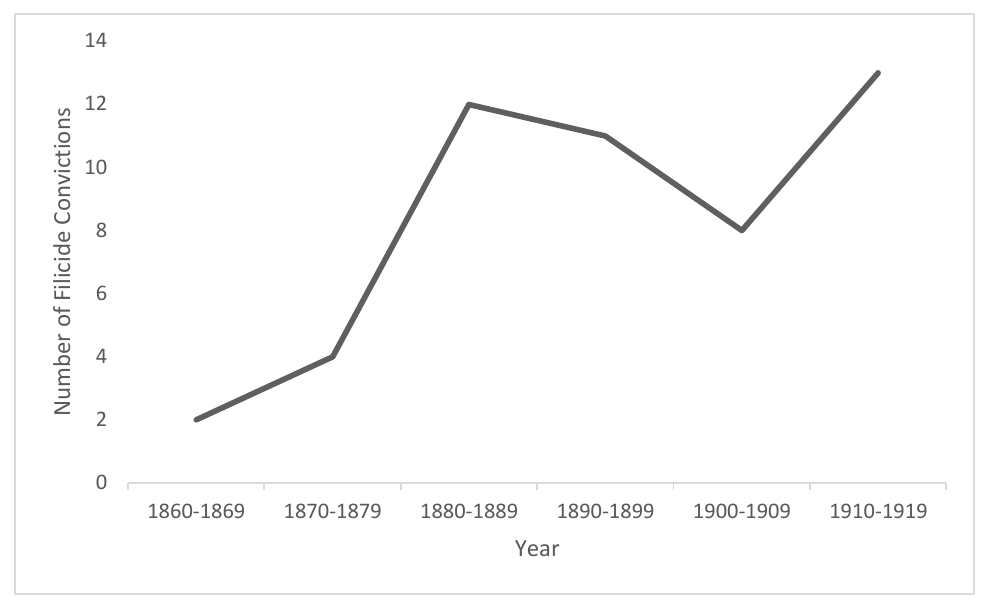
Figure 1: The Frequency of Filicides per Decade in Victoria, 1860 –